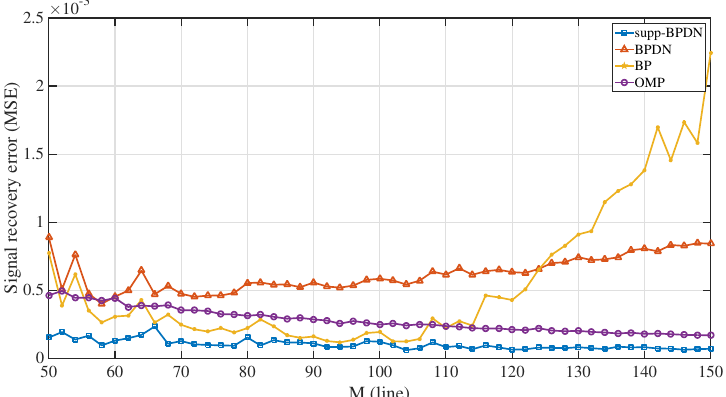
Figure 3. Signal reconstruction error with respect to different numbers of measurements M among supp-BPDN, BPDN, BP, and OMP